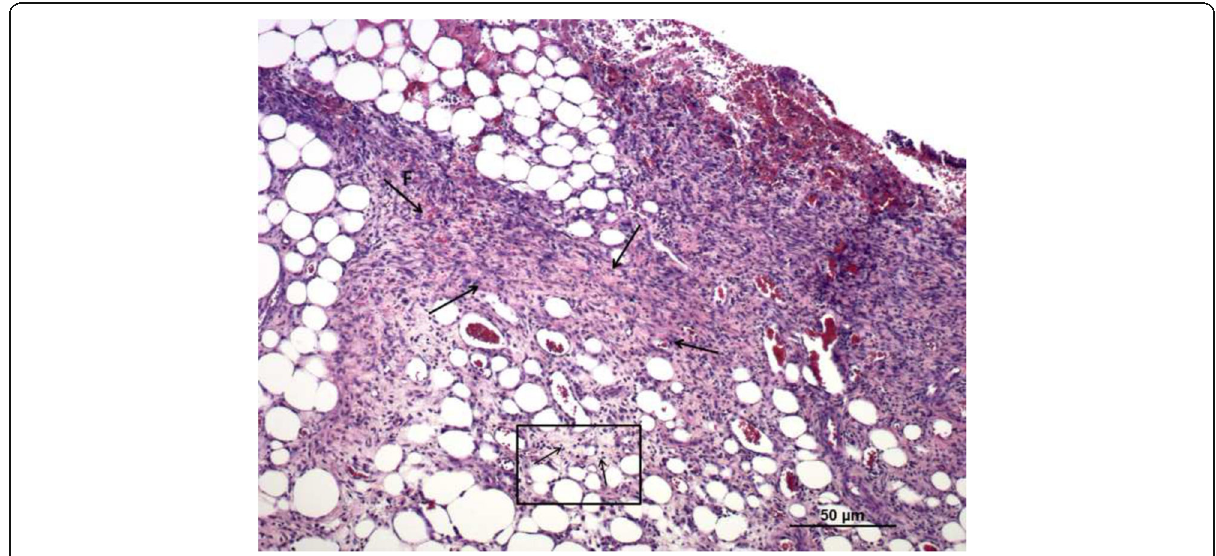
Fig. 3 Histology image of the healed wound with severe dermal fibrosis (F and large arrows ) and interstitial lymphocytic infiltration ( small arrows in the box) (Control